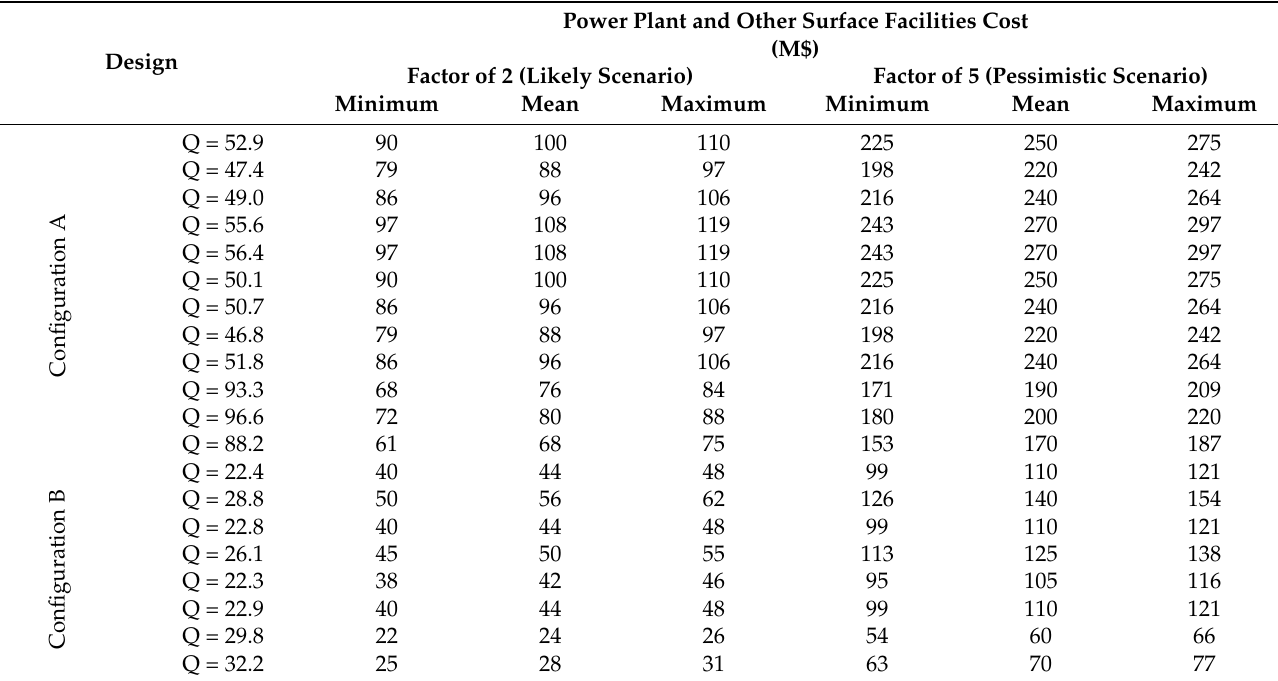
Table 6. Power plant and other surface facilities cost for each simulated design.